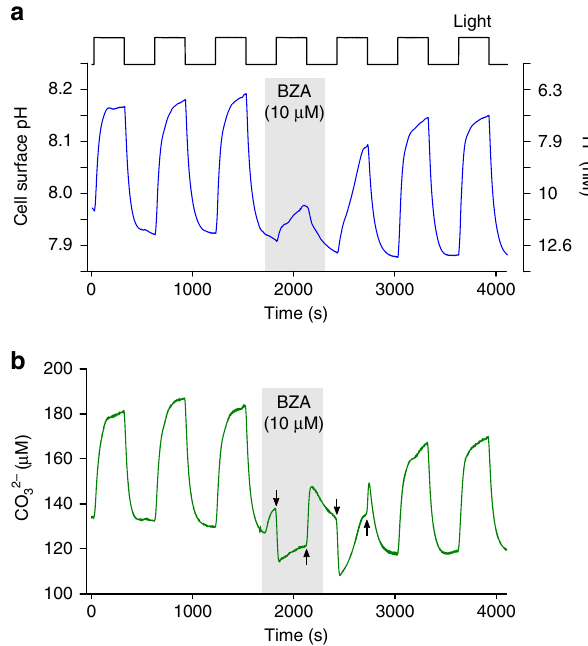
Fig. 6 Simultaneous measurement of pH and CO 3 2 − at the cell surface. a Light-dependent changes in cell surface pH around an O. sinensis cell. b Light-dependent changes in cell surface [CO 3 2 − ] around the cell described in a . In the untreated cell, illumination results in a rapid increase in cell surface [CO 3 2 − ] that very closely mirrors the rise in pH. On addition of 10 µ M benzolamide (BZA), the increase in cell surface pH is dramatically reduced and [CO 3 2 − ] no longer mirrors pH but shows an immediate decrease upon illumination (down arrow), which is restored after the cell is returned to the dark (up arrow). Following the removal of BZA, the light- dependent increase in cell surface pH is rapidly restored, although the decrease in [CO 3 2 − ] persists for one light/dark cycle (arrowed). Note a small increase in [CO 3 2 − ] coincides with the addition of BZA, which is due to slight differences in the carbonate chemistry of the ASW media